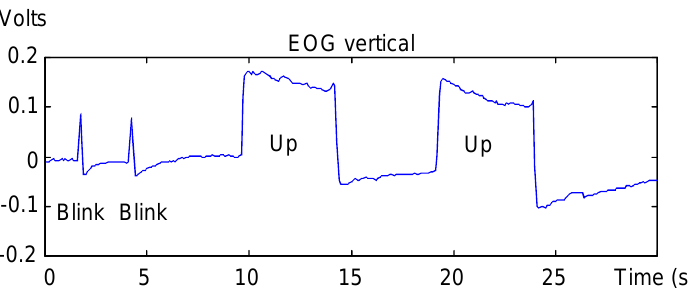
Figure 6. Effect of blinking on the vertical EOG.